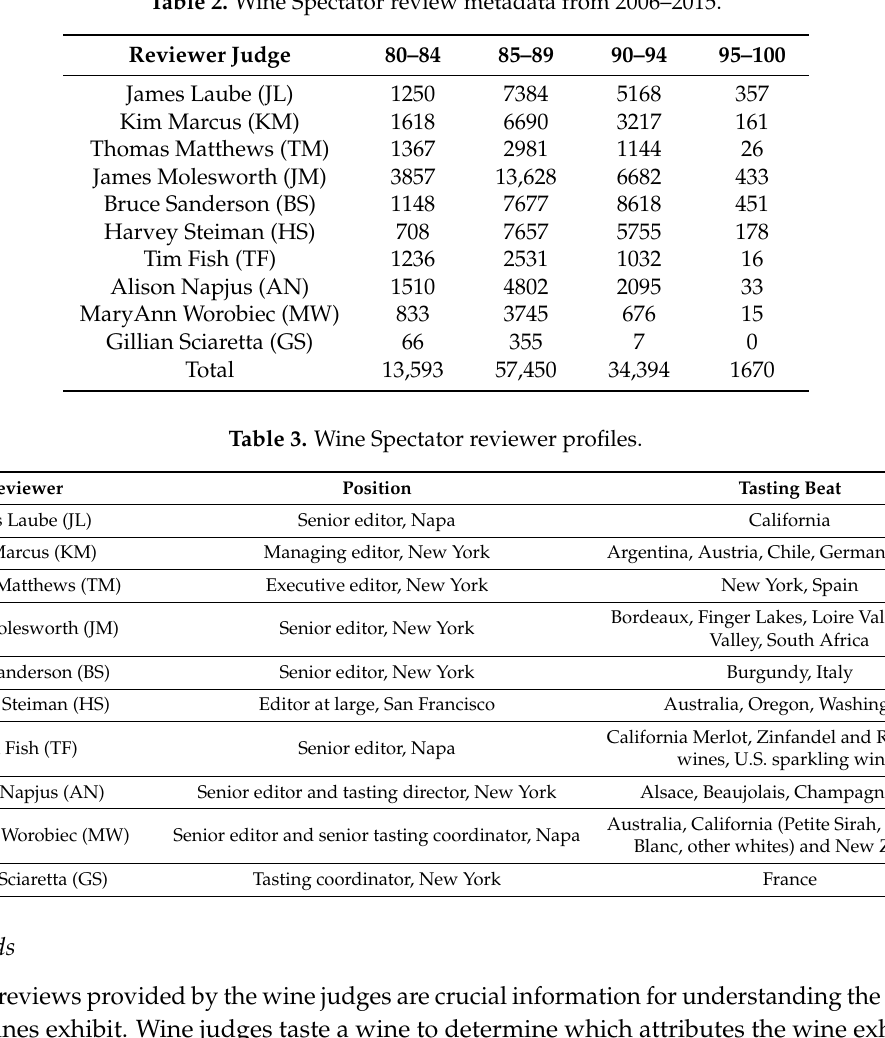
Table 2. Wine Spectator review metadata from 2006–2015.